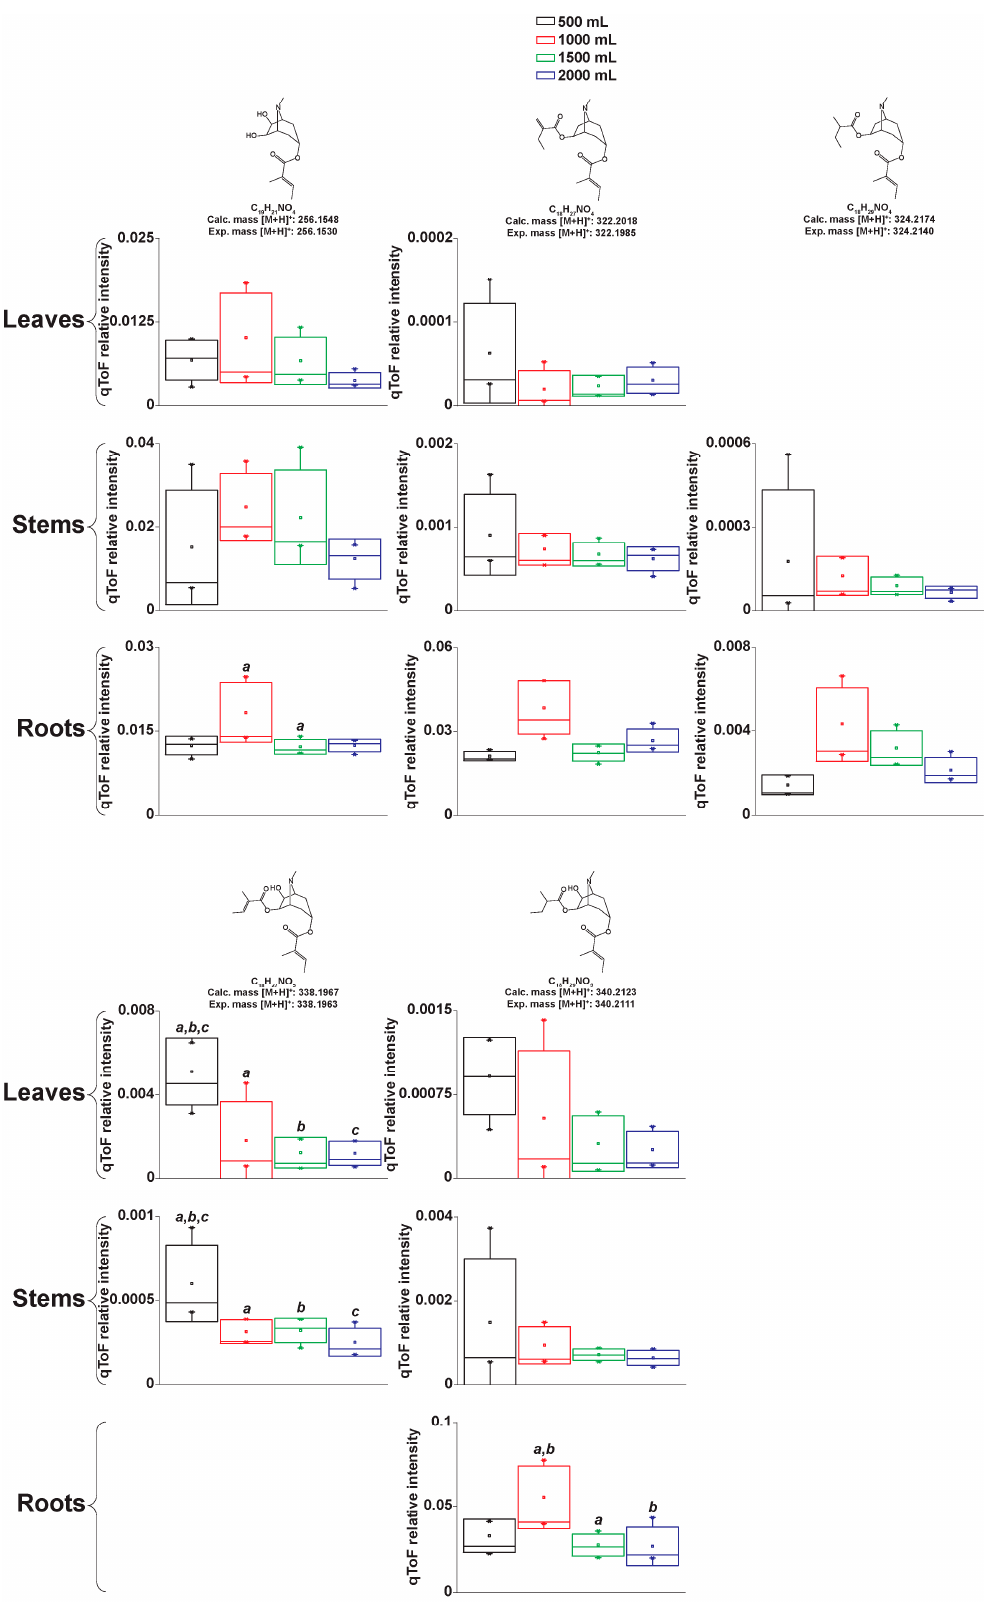
Figure 4. Aliphatic tropane alkaloids and their relative concentrations in Datura stramonium grown under different irrigations. Structures are predictions based on their mass spectra. Box plots show the standard deviation. Letters above bars represent significant pairwise differences according to Tukey test (ANOVA p ≤ 0.05).